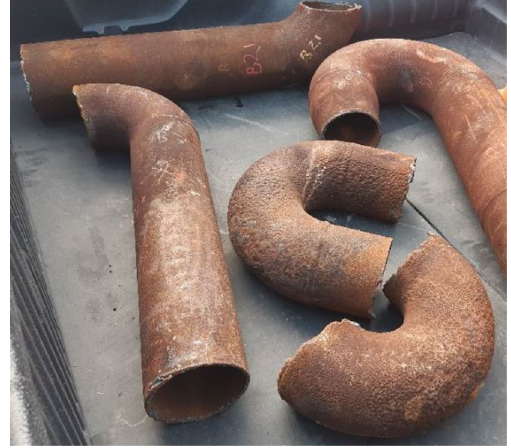
Figure 2. Investigation